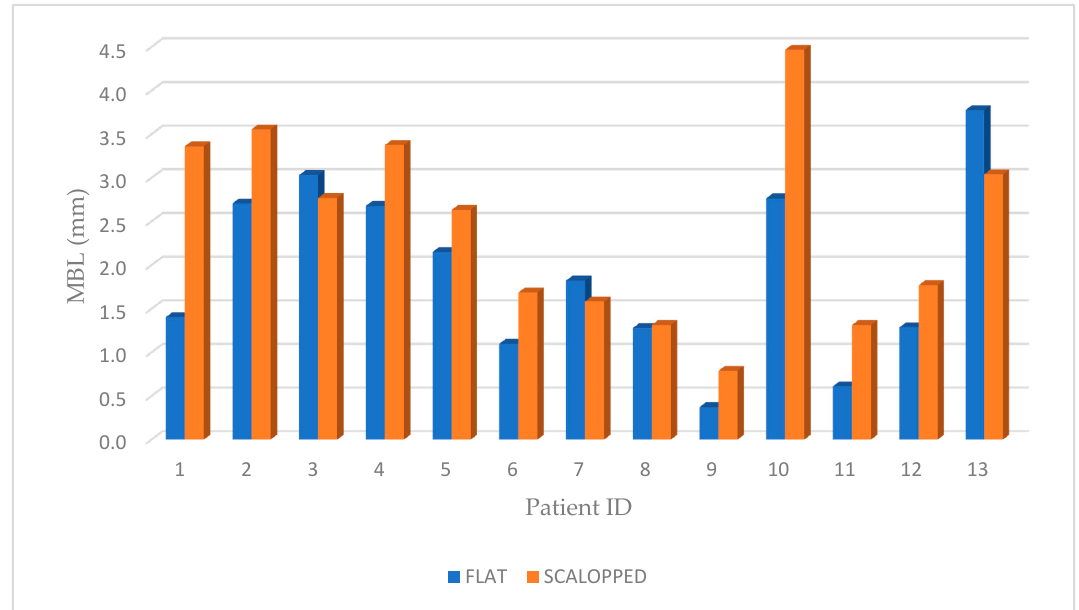
Figure 6. Graphic representation of MBL of both groups at T1, after 4 years follow-up (T1 - T0), where a statistically significant difference was shown between the test (scalloped) and control (flat) groups (P = 0.02).